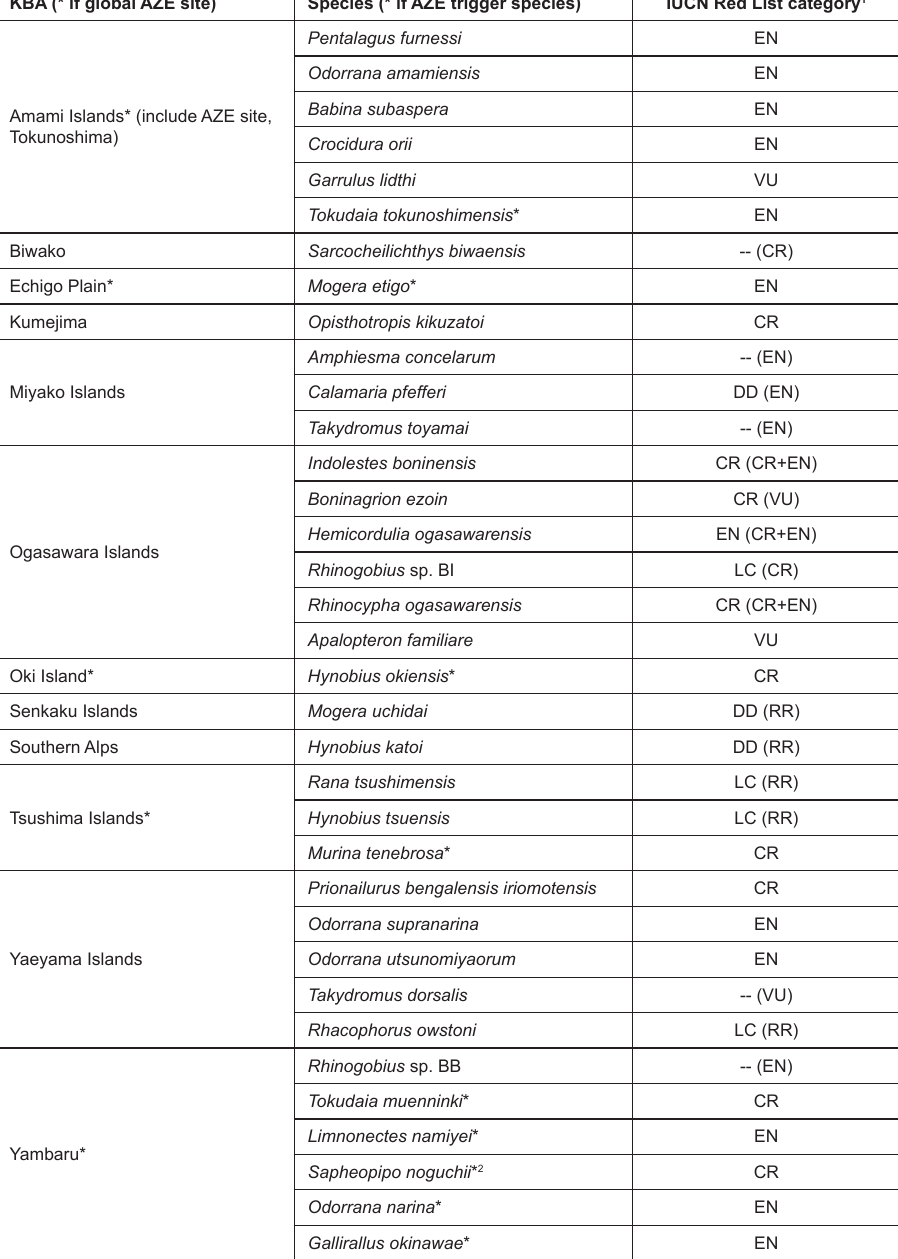
Table 5. Species occurring at only one KBA